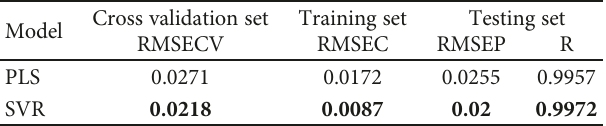
Table 4: Performance of PLS and SVR in carbendazim and rice powder